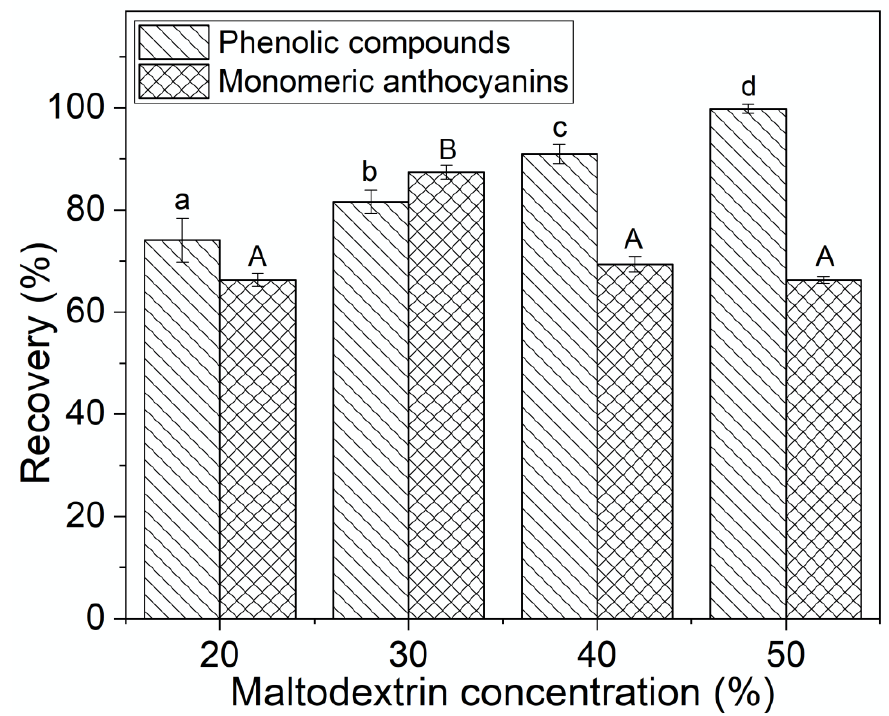
Figure 5. Recovery (%) of the total polyphenol content and total monomeric anthocyanin in freeze-dried Andean blueberry juice powders with di ff erent concentrations of maltodextrin. Values with di ff erent superscript letters are significantly di ff erent ( p < 0.05).